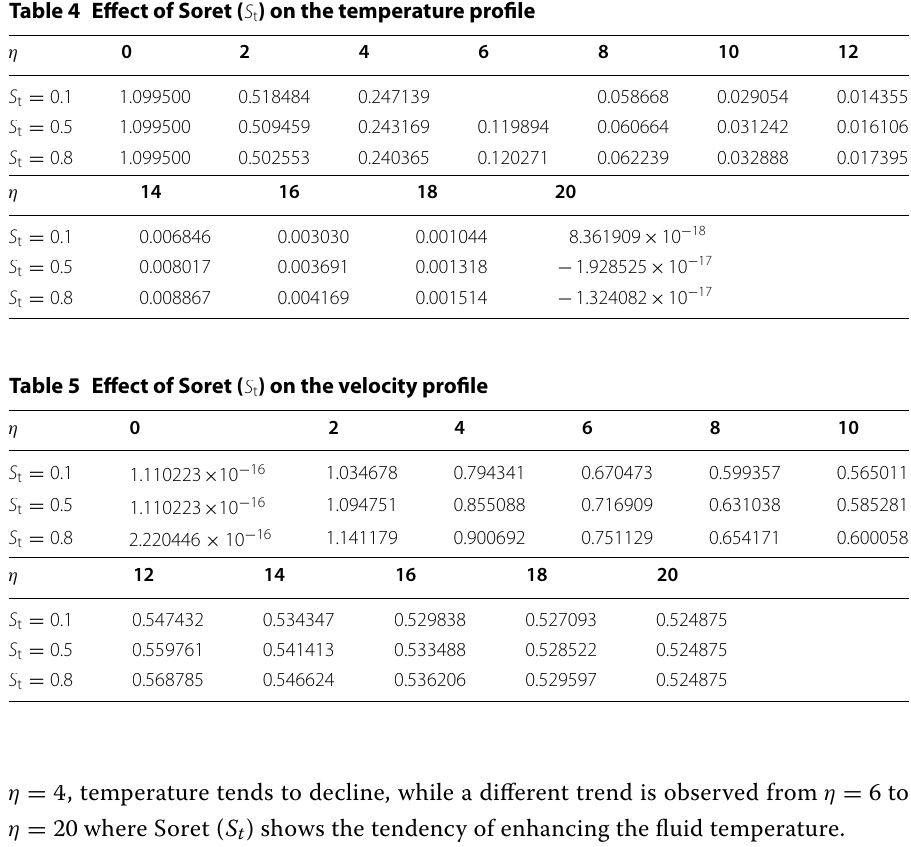
Table 4 Effect of Soret ( S t ) on the temperature profile η 0 2 S t = 0.1 S t = 0.8